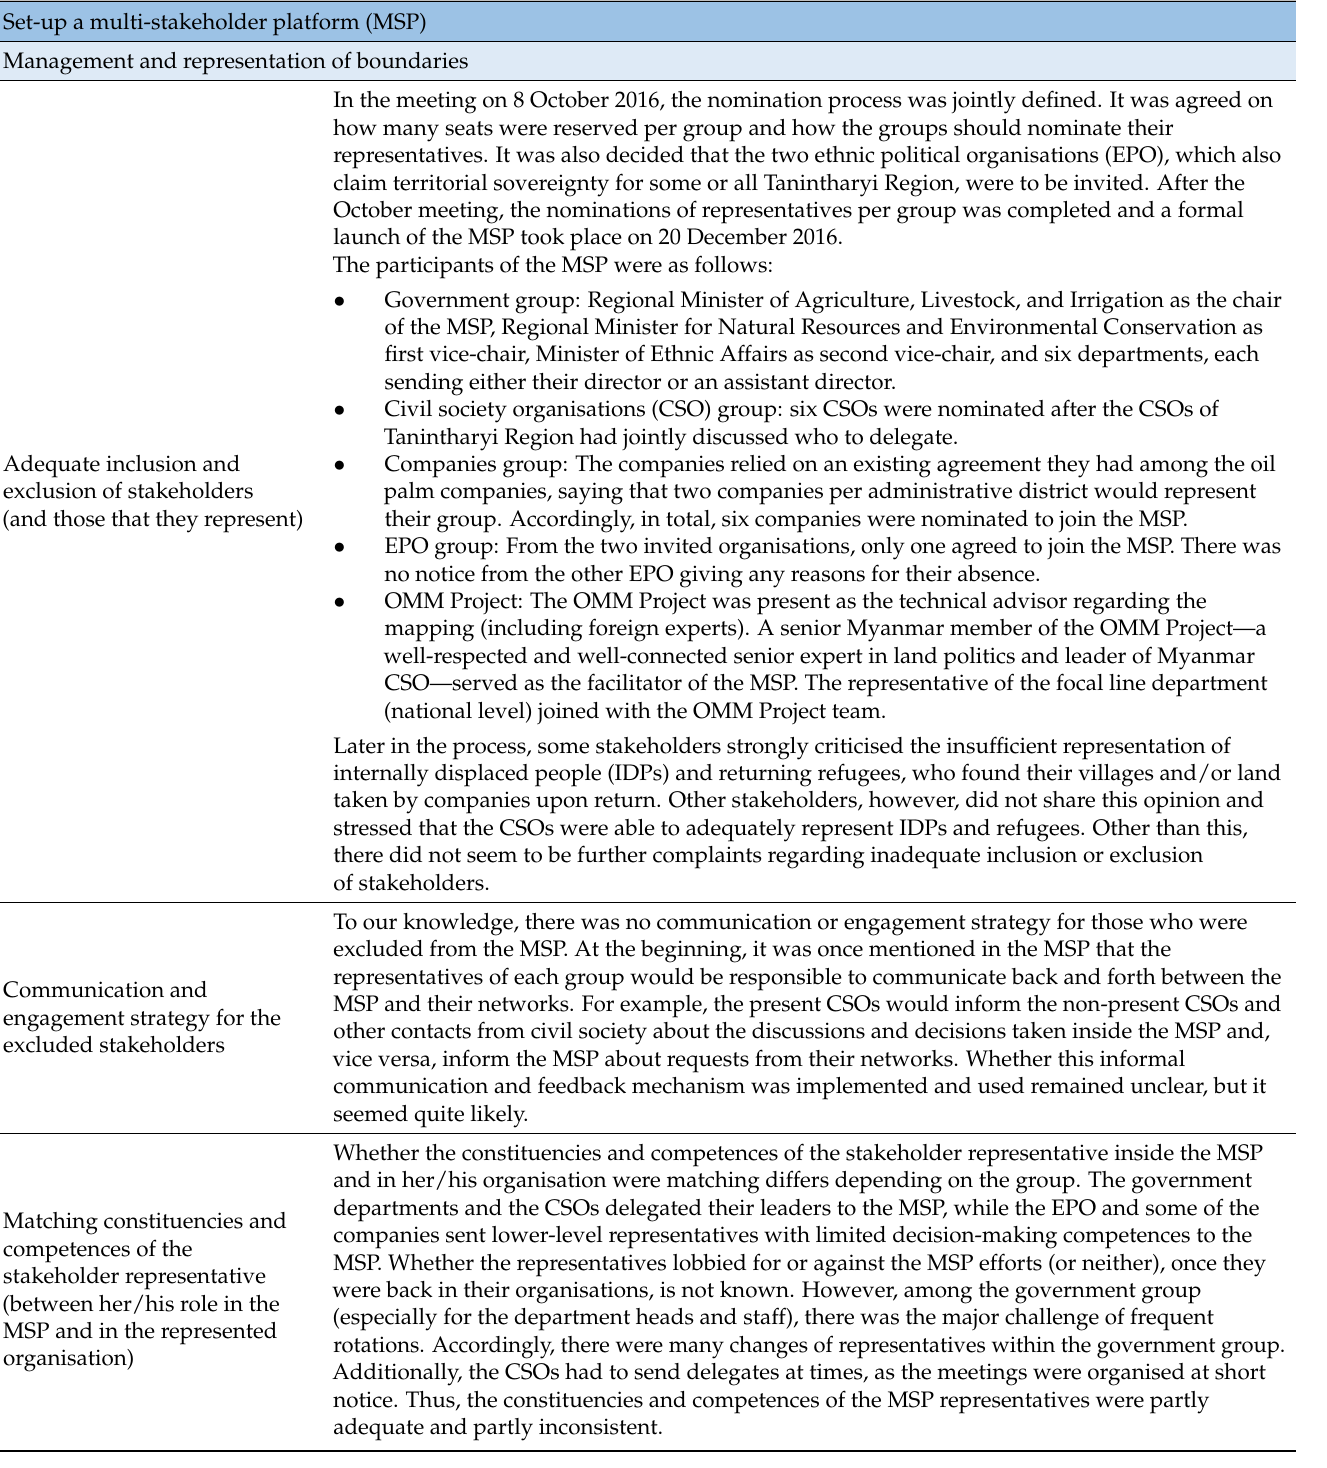
Table A1. Design and governance of the multi-stakeholder platform—detailed overview of results. Criteria for Effective Multi-Stakeholder Platforms